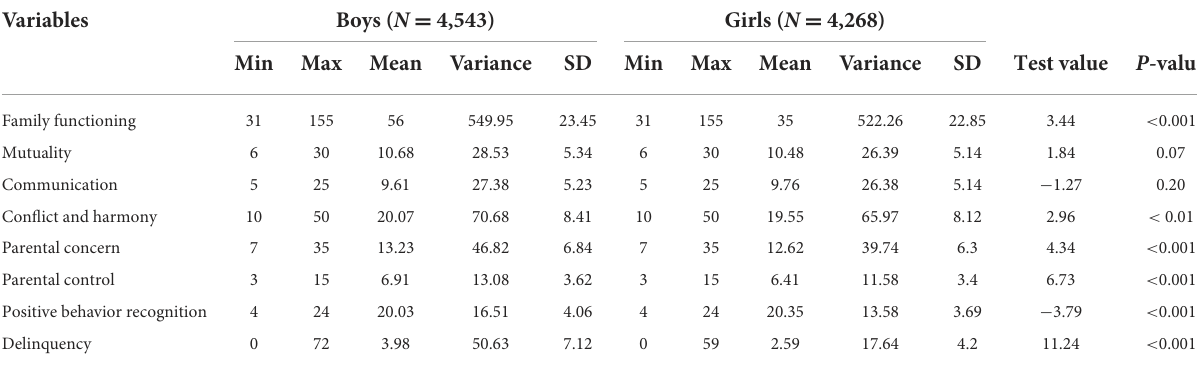
TABLE 2 Descriptive statistics of the participants on delinquency, family functioning, and positive behavior